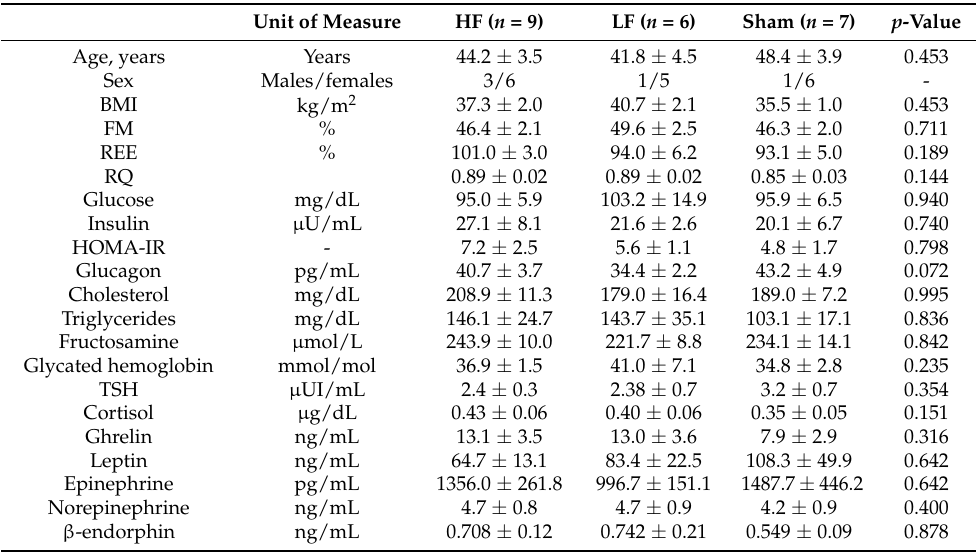
* Data are shown as mean ± standard error of the mean (SEM) except for sex. Comparisons among groups were obtained with ANOVA followed by Bonferroni post-hoc test for normally distributed values and with Kruskal– Wallis for non-normally distributed values. Abbreviations: HF = high frequency; LF = low frequency; BMI = body mass index; FM = fat mass; REE= resting energy expenditure; RQ = respiratory quotient; HOMA-IR= homeostatic model assessment-insulin resistance; TSH = thyroid-stimulating hormone.